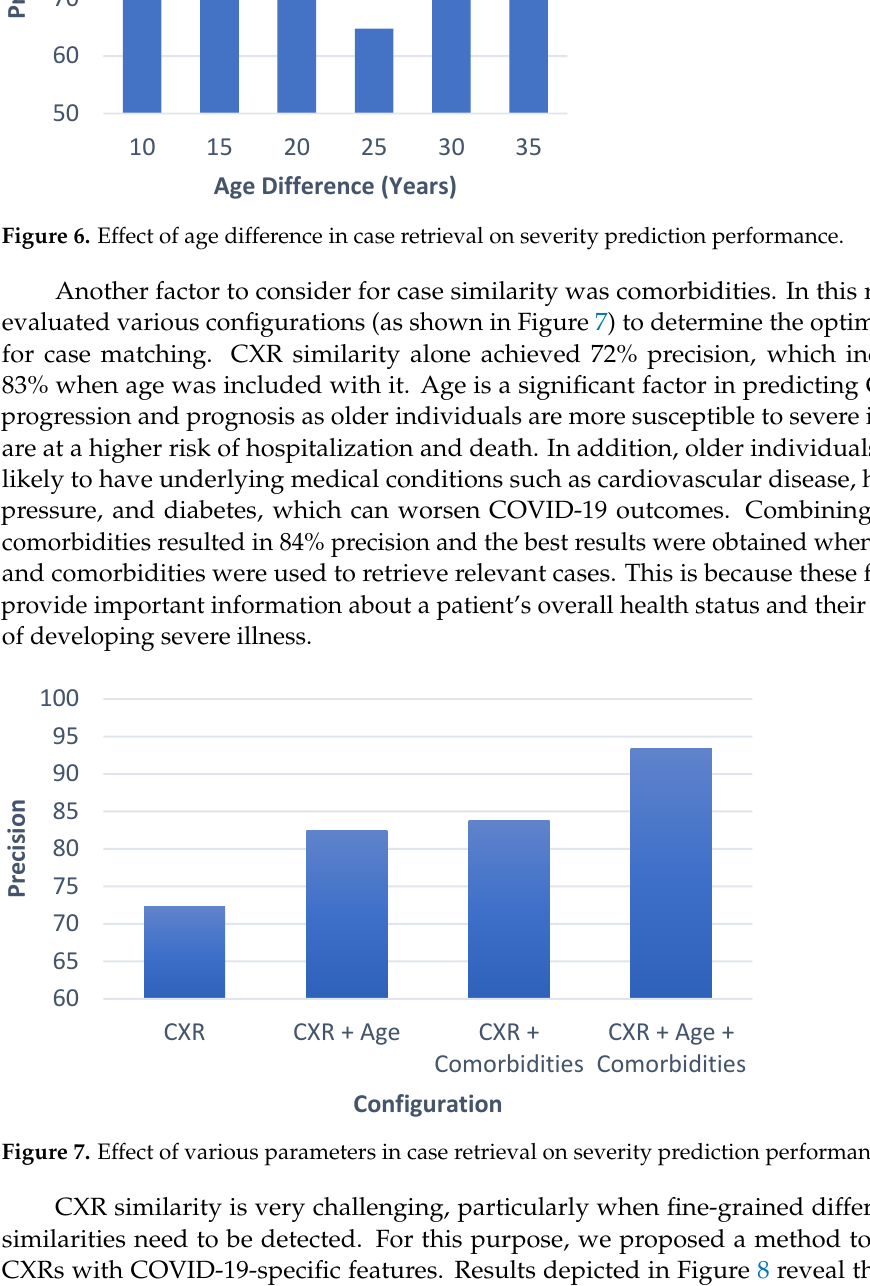
Figure 6. Effect of age difference in case retrieval on severity prediction performance.